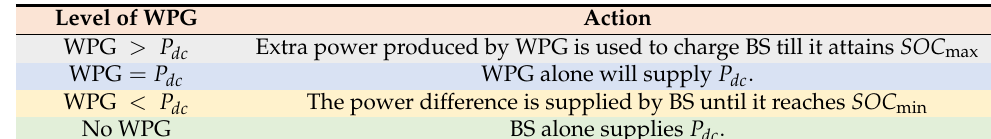
Table 3. Power-sharing at DC-link